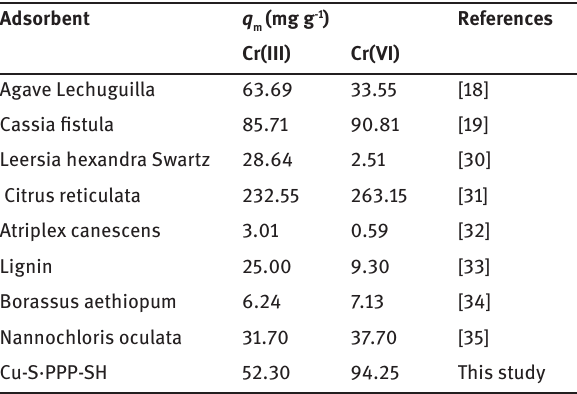
Table 2: The list of some agriculture by-products for adsorption of Cr(III) and Cr(VI) in the literature. Adsorbent